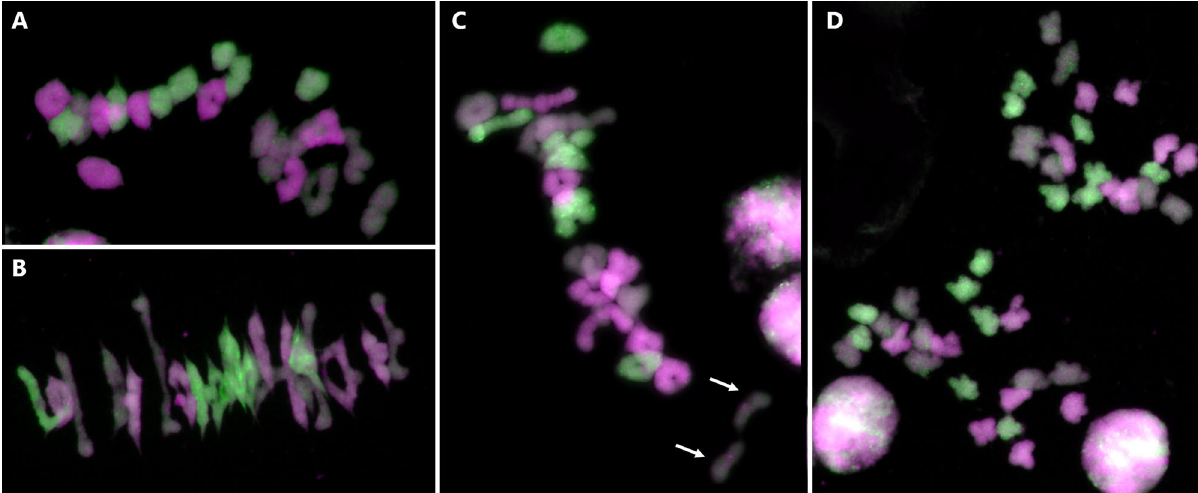
Figure 3. Genomic in situ hybridization (GISH) of meiotic metaphase I ( A – C ) and anaphase I ( D ) spreads in the zip4-ph1d mutant. A-genome chromosomes are shown in magenta, B-genome chromosomes in grey and D-genome chromosomes in green. ( A ) Representative metaphase I configurations showing 21 ring bivalents, ( B ) metaphase I showing 16 ring and 5 rod bivalents, and ( C ) metaphase I with 16 ring bivalents, 4 rod bivalents and 2 univalents indicated by an arrow. In ( D ), a representative anaphase I showing correct chromosome